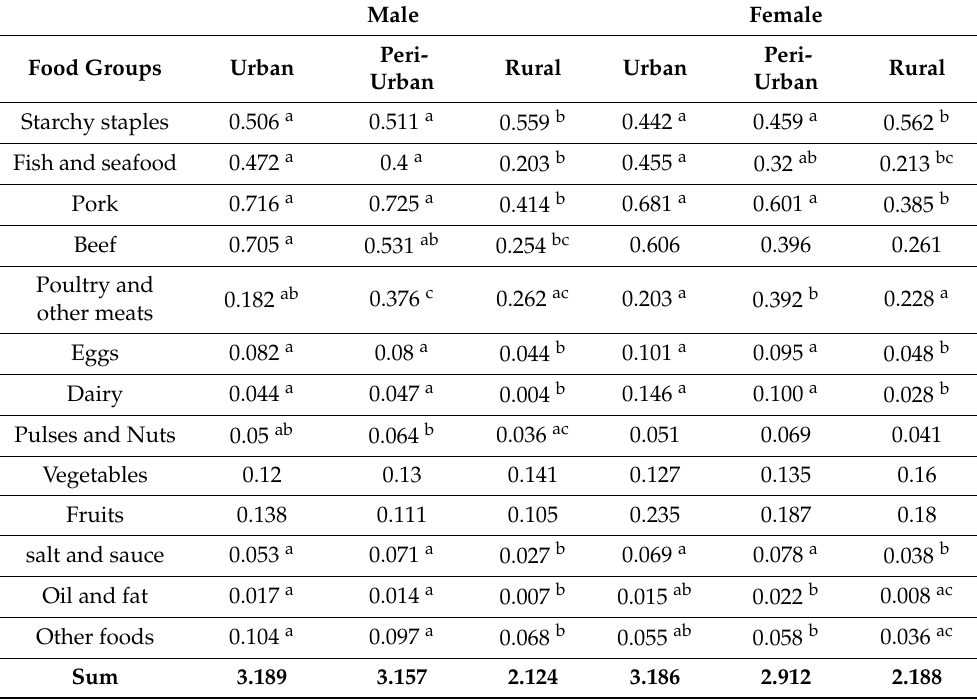
Table A6. GHGE per 2000 Kcal by food group, gender, and